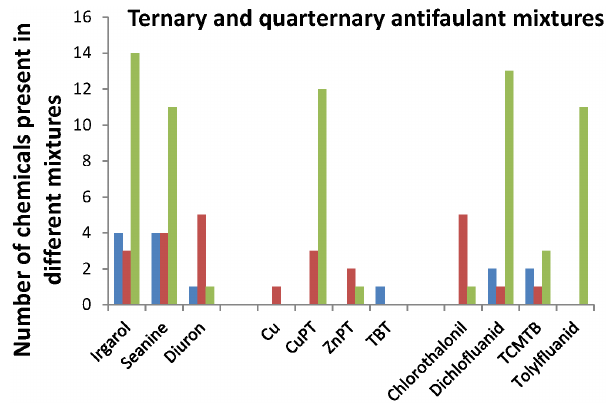
Figure 5. Frequency of antifoulant interactions in ternary and quaternary mixtures. The number of times each of the antifoulants occur in a ternary ( n =23) or quaternary ( n =10) mixture resulting in antagony (blue bars), concentration additivity (CA) (red bars) or synergy (green bars).